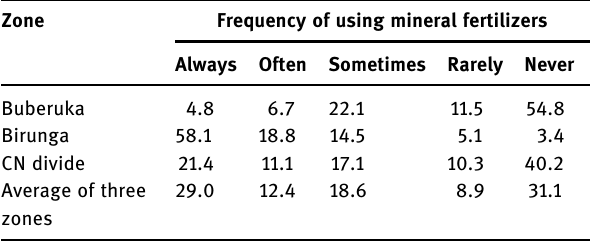
Source: computed from household fertilizer survey